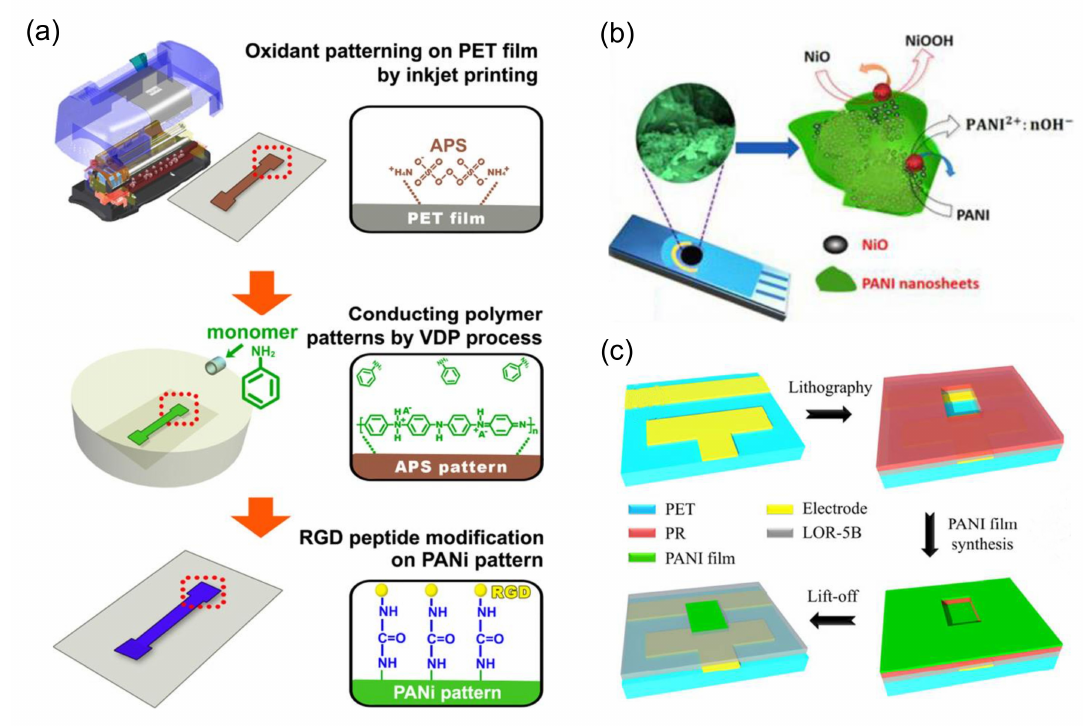
Figure 6. ( a ) Patterned 2D PANI structures via inkjet printing and vapor deposition